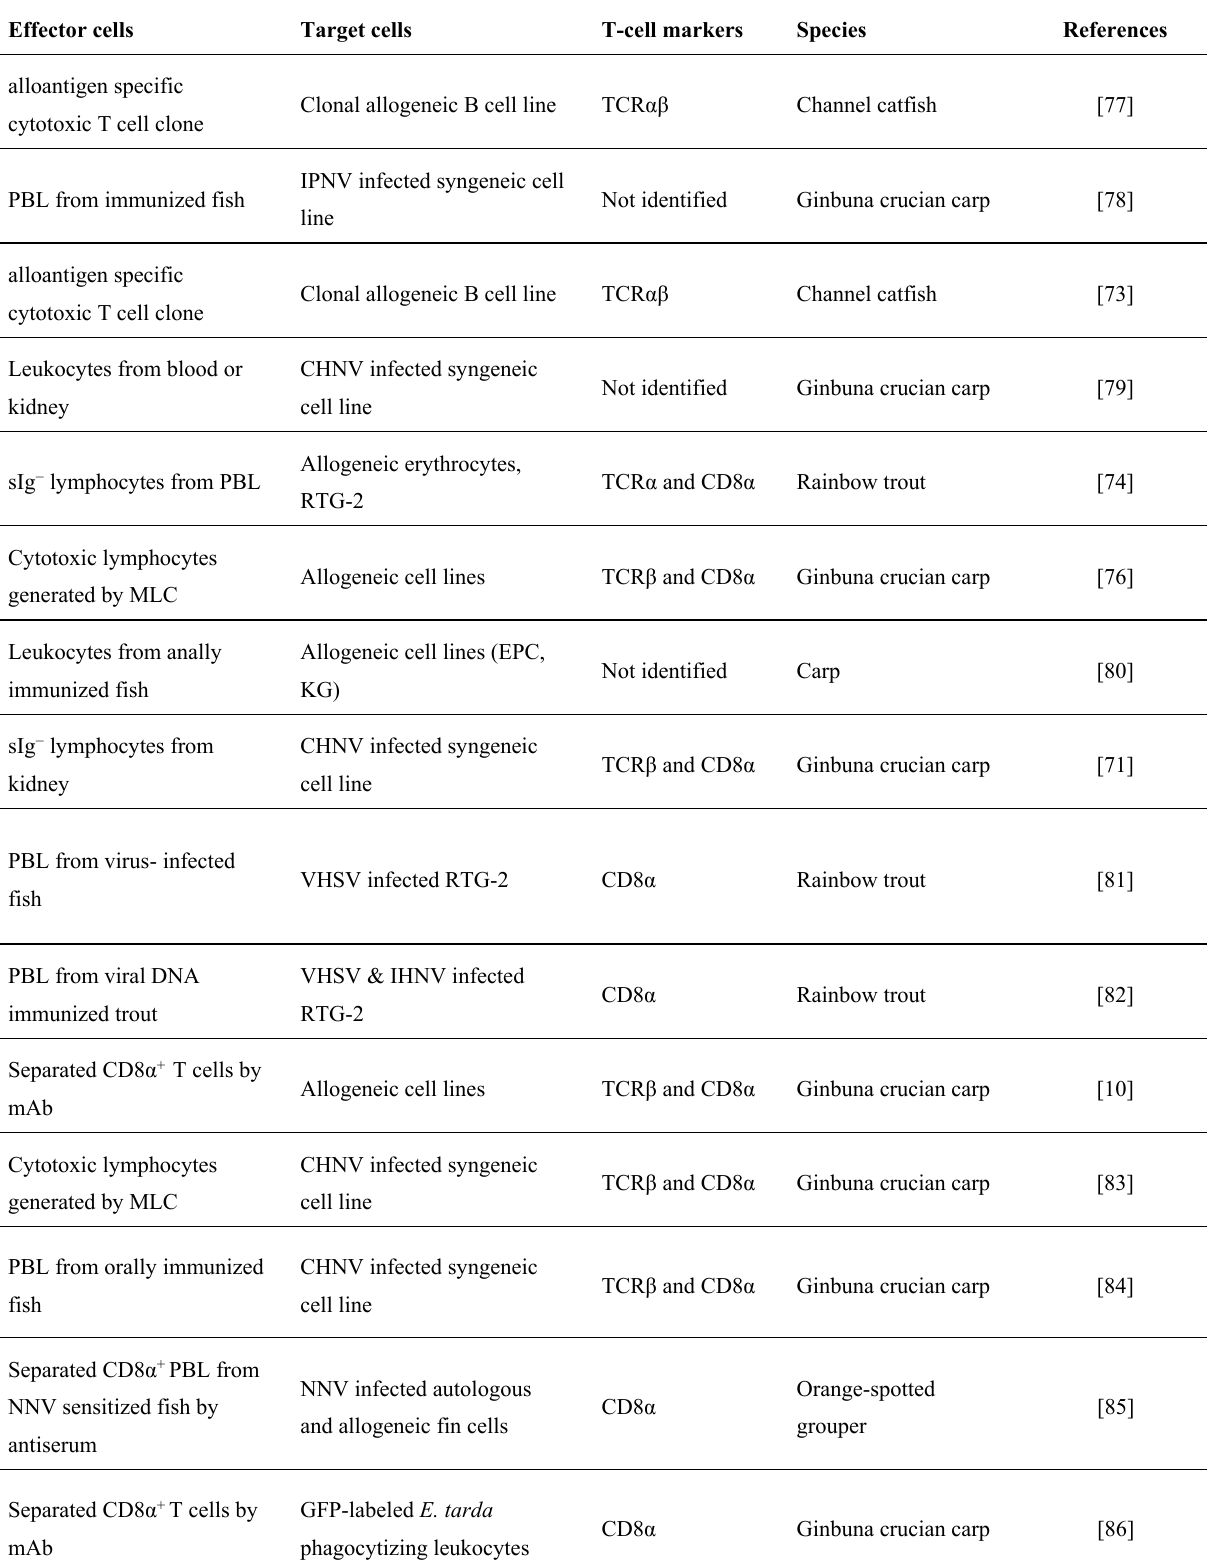
Table 2. Identification of CTLs involved in specific cell-mediated cytotoxicity in